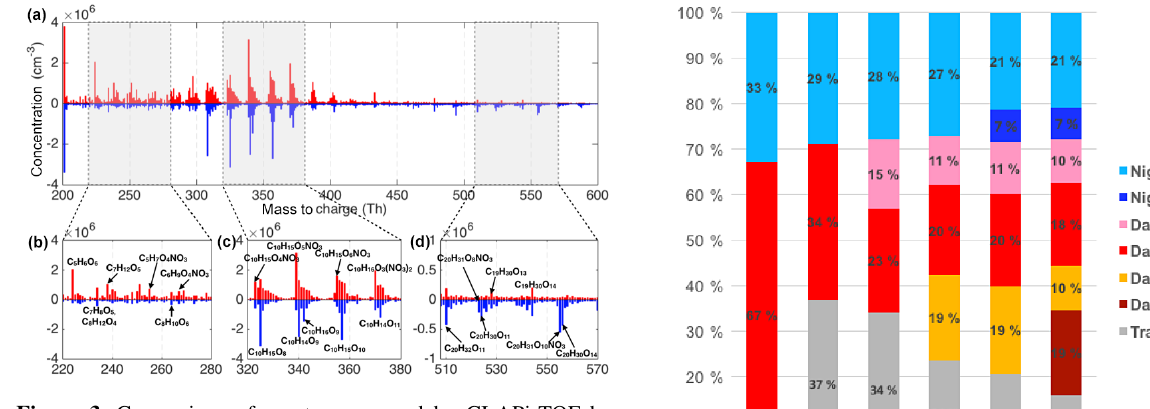
Figure 3. Comparison of spectra measured by CI-APi-TOF be- tween daytime and nighttime. The daytime spectrum (marked in red) is above the zero line and the nighttime spectrum (marked in blue) is below the zero line. Figure 3b, c, and d present expanded mass spectra where major peaks are labeled with their possible ele- mental formula.